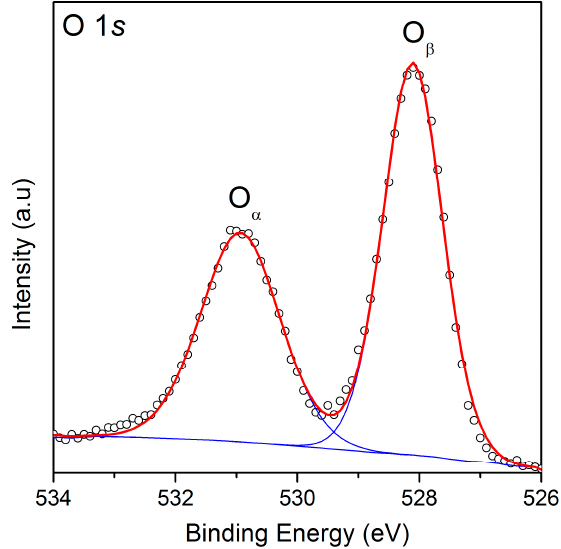
Figure 4. Deconvoluted XP spectrum of the Ce50Pr50 catalyst in the O 1s core level region.